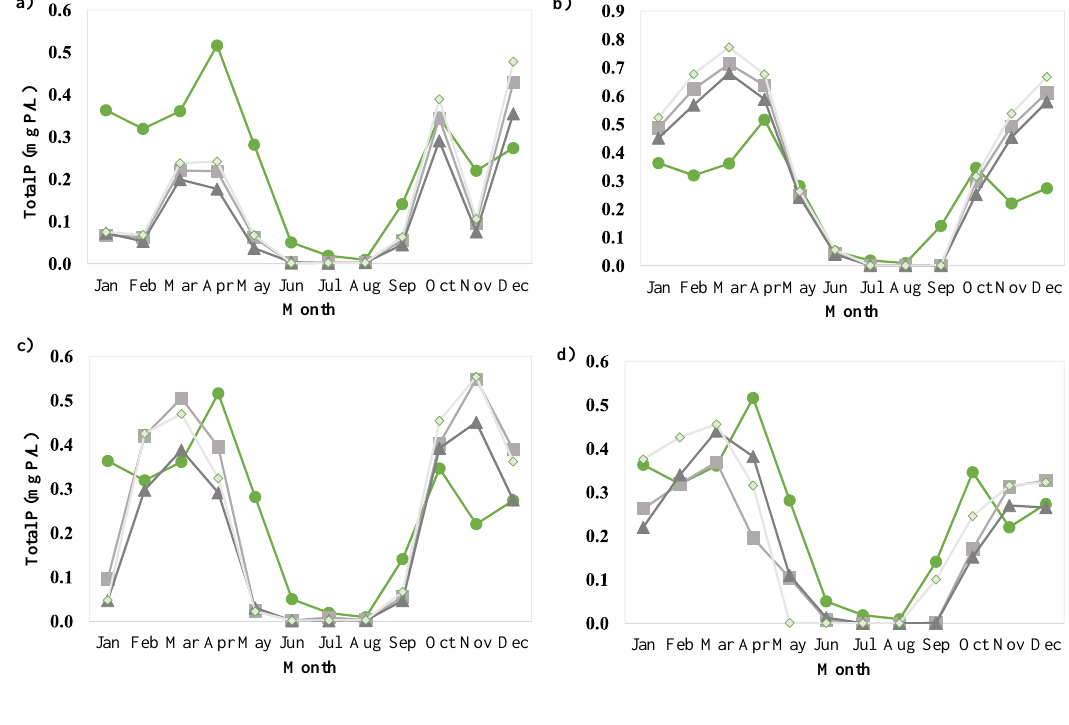
Figure 10. The monthly average of the modelled Total P concentration (mg P L − 1 ) for each storyline and baseline: ( a ) 2030-GFDL; ( b ) 2060-GFDL; ( c ) 2030-IPSL; ( d ) 2060-IPSL. For clarification on the modelled scenarios, please see Figure 2.